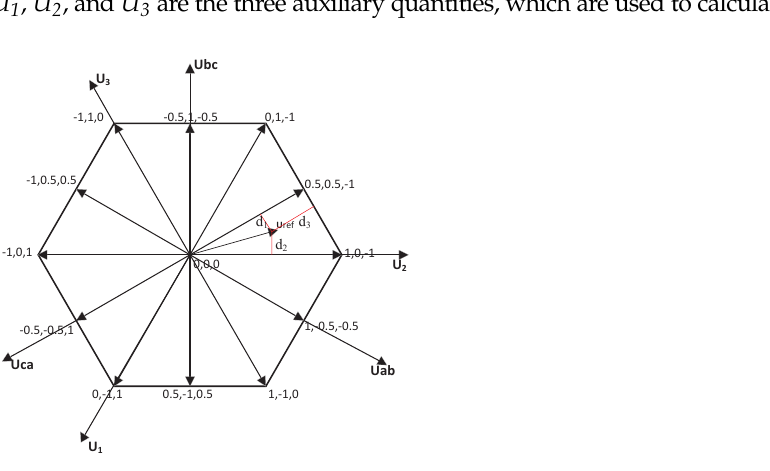
Figure 6. The coordinate system of LMZVM after adding three coordinate